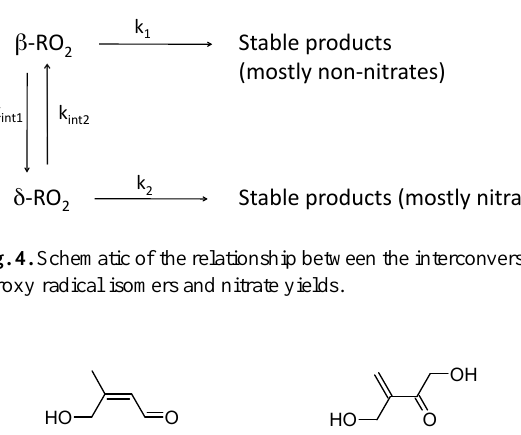
Fig. 4. Schematic of the relationship between the interconversion of peroxy radical isomers and nitrate yields Fig. 3. Formation mechanisms of methyl vinyl ketone (a) , methacrolein (b) , 3-methylfuran (c) , and hydrox- Fig. 3. Formation mechanisms of methyl vinyl ketone (a) , ycarbonyl (d) , leading to release of NO 2 . The exact mechanism of 3-methylfuran formation is still uncertain methacrolein (b) , 3-methylfuran (c) , and hydroxycarbonyl (d) , lead- (Francisco-Marquezetal.,2005). ing to release of NO 2 . The exact mechanism of 3-methylfuran for- mation is still uncertain (Francisco-Marquez et al., 2005).